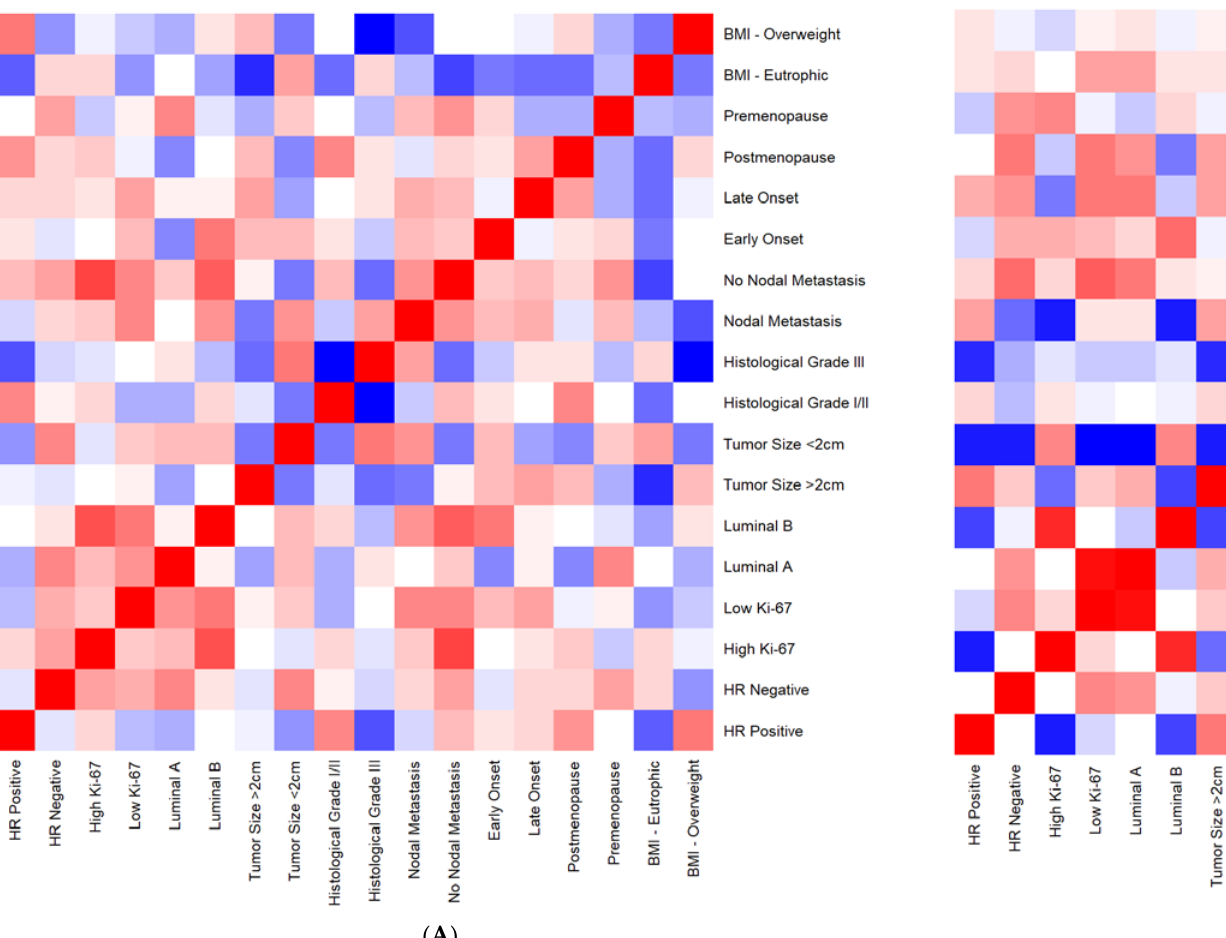
Figure 4. Heatmap: correlation analysis of clinicopathological data according to systemic levels of IL-12 of exposed and unexposed breast cancer patients from intermediate-risk stratification. ( A ) Exposed group. ( B ) Unexposed group. The analysis was performed with R programming language (R Development Core Team. 2021). Red squares indicate positive correlations. Blue squares indicate the negative ones. A more intense color indicates a stronger correlation.